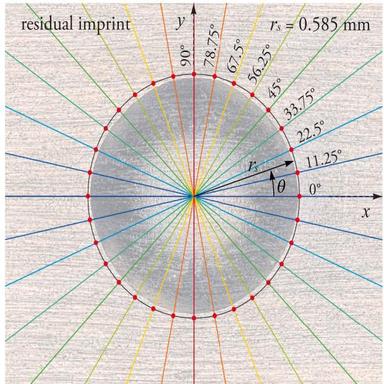
Methodology for recording the pile-up height at the characteristic radius rs (black circle) for each 11.25◦ around the circumference. The measurement points are shown in red, while scan lines belonging to the same symmetry group are shown in the same colour.